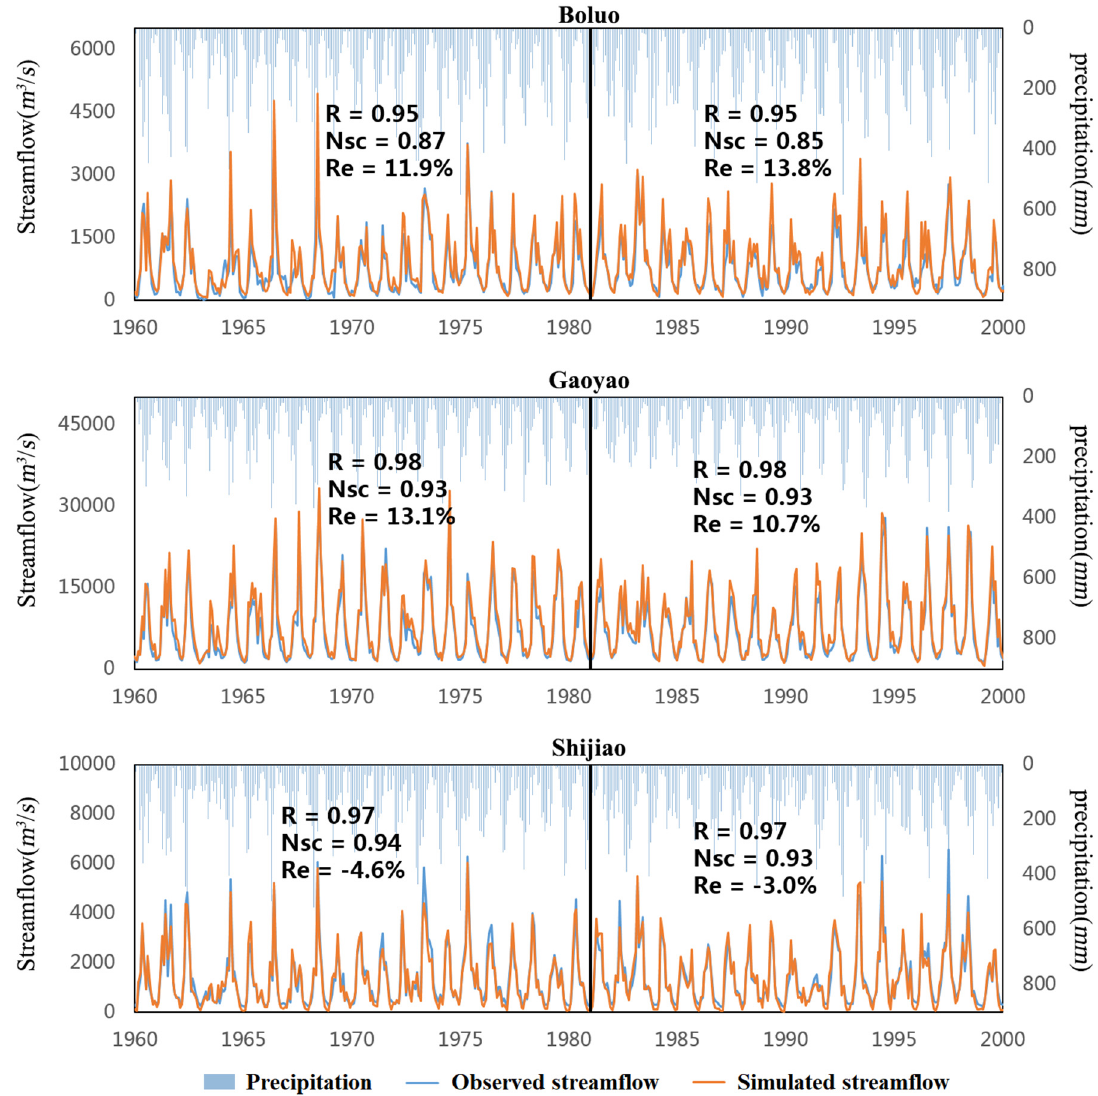
Figure 2. Calibration and validation results of the VIC model.